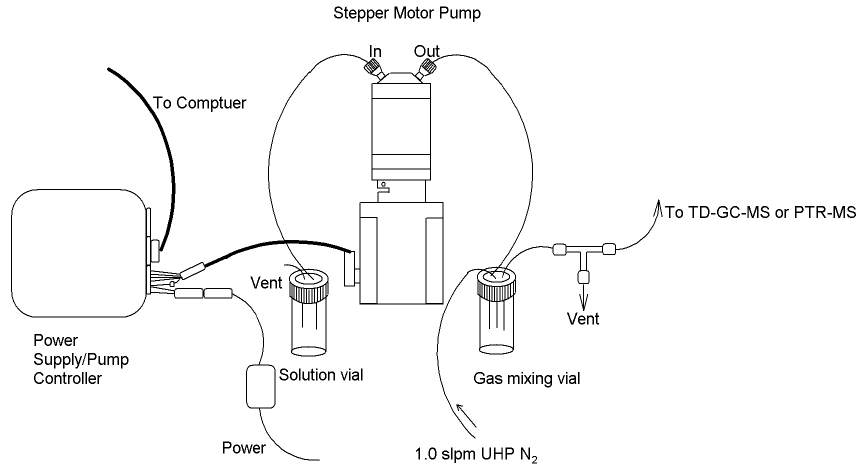
Fig. 1. Diagram of the Dynamic Solution Injection (DSI) system. A calibration solution vial is connected to the inlet of a liquid stepper motor pump that injects a known flow of liquid into a gas mixing vial where 1.0 slpm of dilution gas (UHP nitrogen or air) is added.